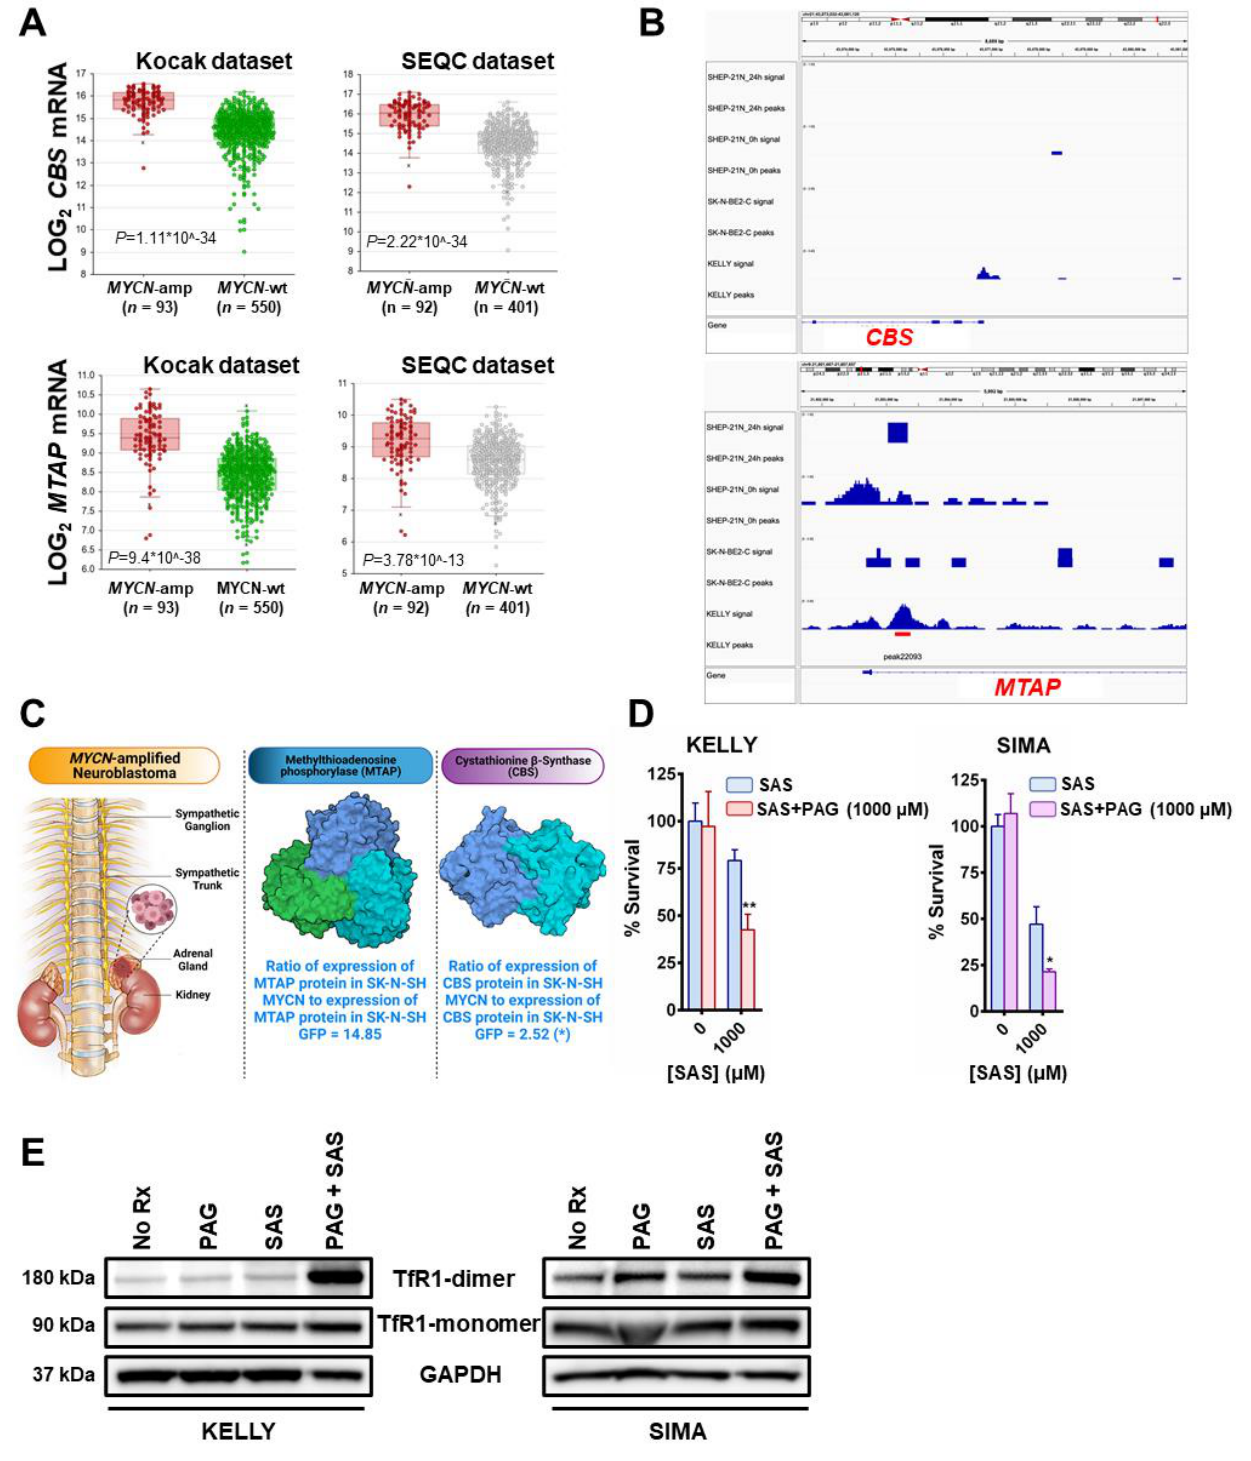
FIGURE 2: MYCN induces the transsulfuration pathway to further protect neuroblastomas from ferroptotic cell death. (A) Box plots from datasets obtained from R2 platform demonstrating differential RNA expression of CBS and MTAP enzymes in MYCN -amplified neuroblastoma tumors compared with MYCN -wt neuroblastoma tumors. Mann – Whitney test was performed. (B) MYCN signal in the promoters of MTAP and CBS genes in the corresponding neuroblastoma cell lines. 24 h - signal post MYCN shutdown. Signal tracks were scaled to the same range for comparison. Red bar represents statistically significant MYCN binding in the MTAP promoter and lack of binding in the CBS promoter. (C) Fold- change in the expression levels of CBS and MTAP proteins between SK-N-SH MYCN and SK-N-SH GFP cells analyzed by LC-MS.